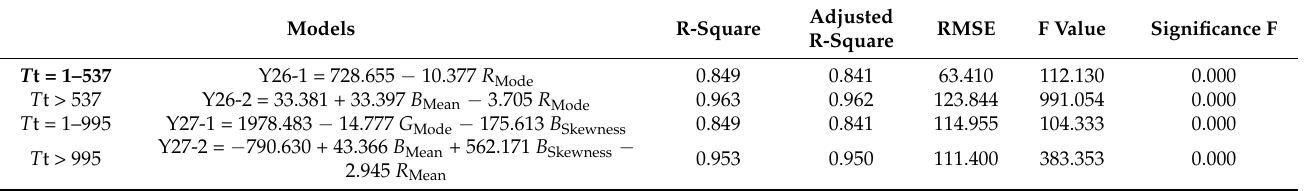
Table 5. The piecewise inversion model of accumulated temperature to canopy color based on the points of demarcation.